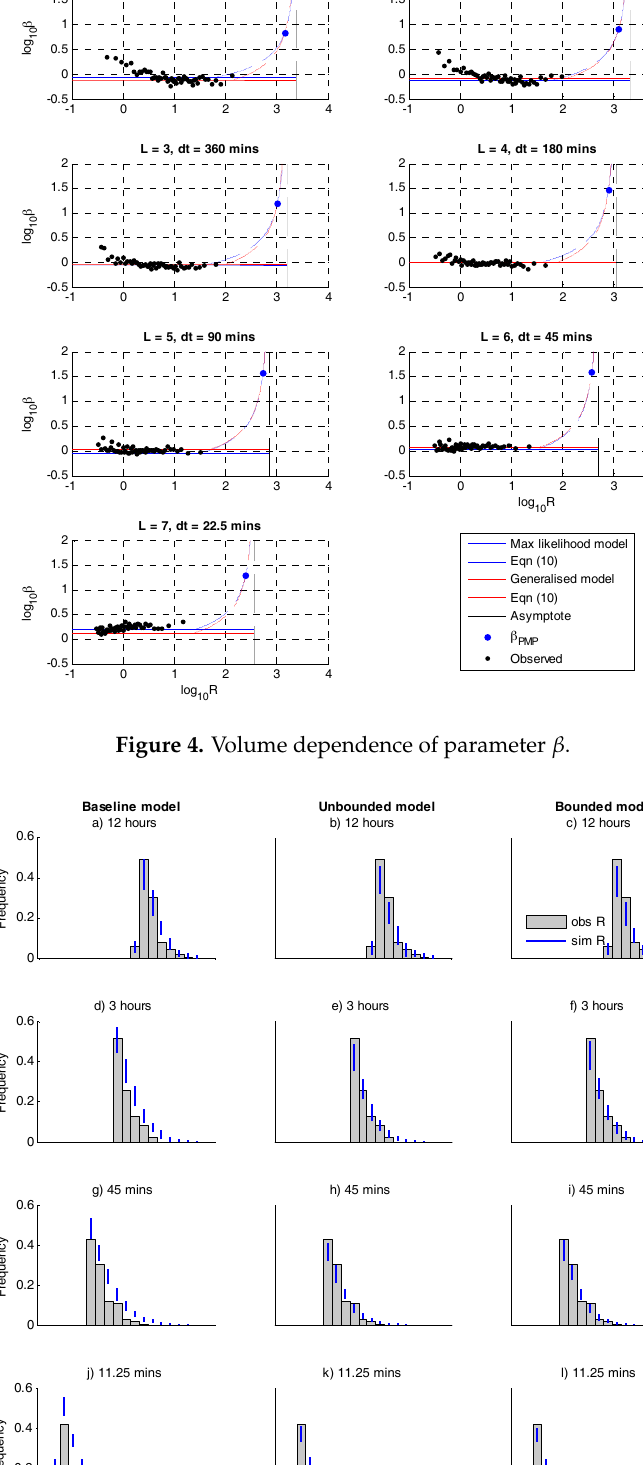
Figure 5. Comparison of observed and simulated extreme rainfall using the baseline, unbounded and bounded models.